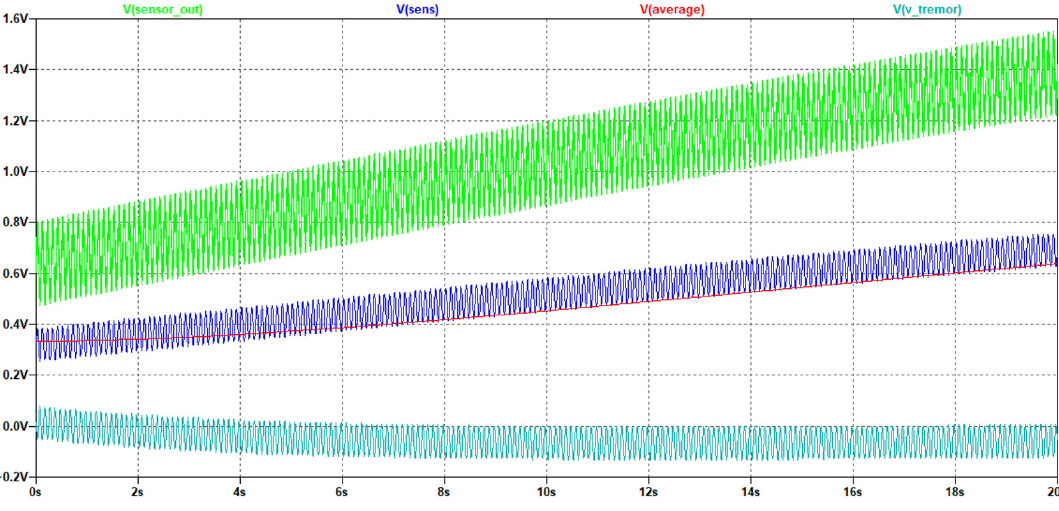
Figure 6. Simulation result.